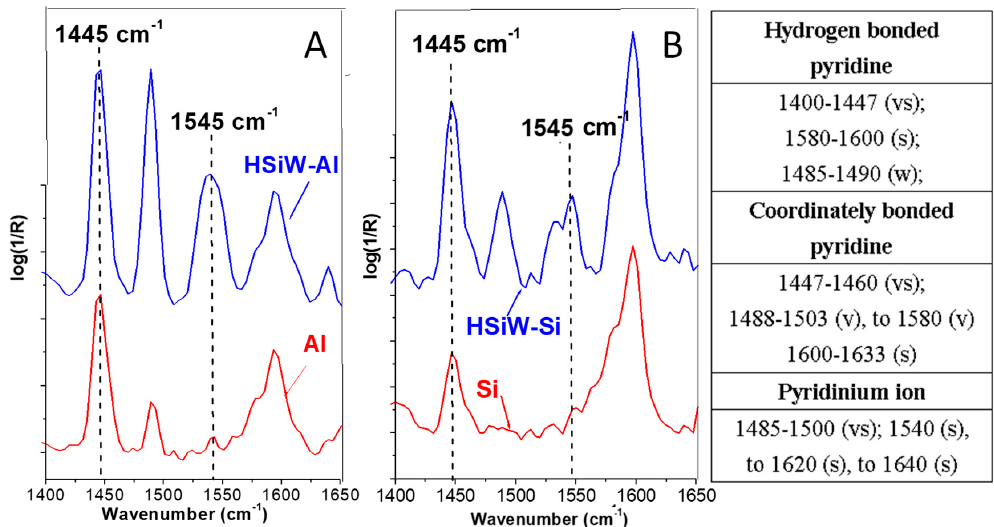
Figure 3. Py-FTIR spectra of ( A ) Al and HSiW-Al (regular 30 wt.% acid loading), and ( B ) Si and HSiW-Si (regular 20 wt.% acid loading). The responsive peak information is summarized in the imbedded table (vs: very strong; s: strong; v: variable; w: weak) [35].